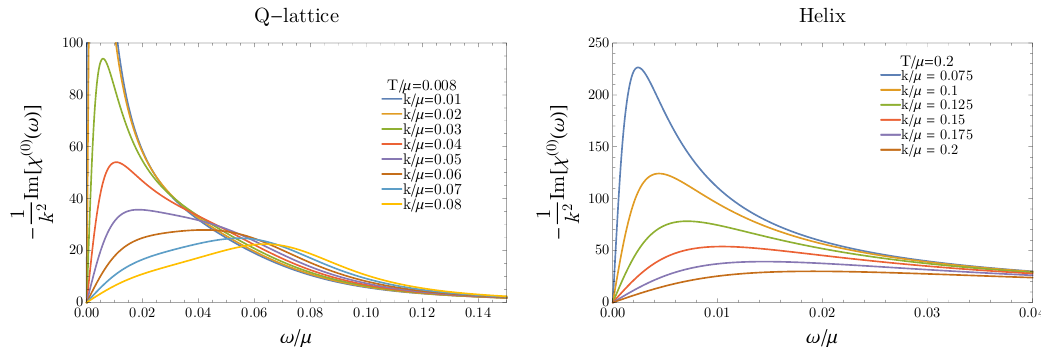
Figure 5. Neutral density response function at low temperature for various wave-vectors. Due to the strong momentum relaxation, the dispersive sound peak is completely removed and the spectrum is dominated instead by characteristic di(cid:11)usion peak. This peak disappears at larger wave-vectors because the corresponding quasinormal mode moves further down in the complex plane.